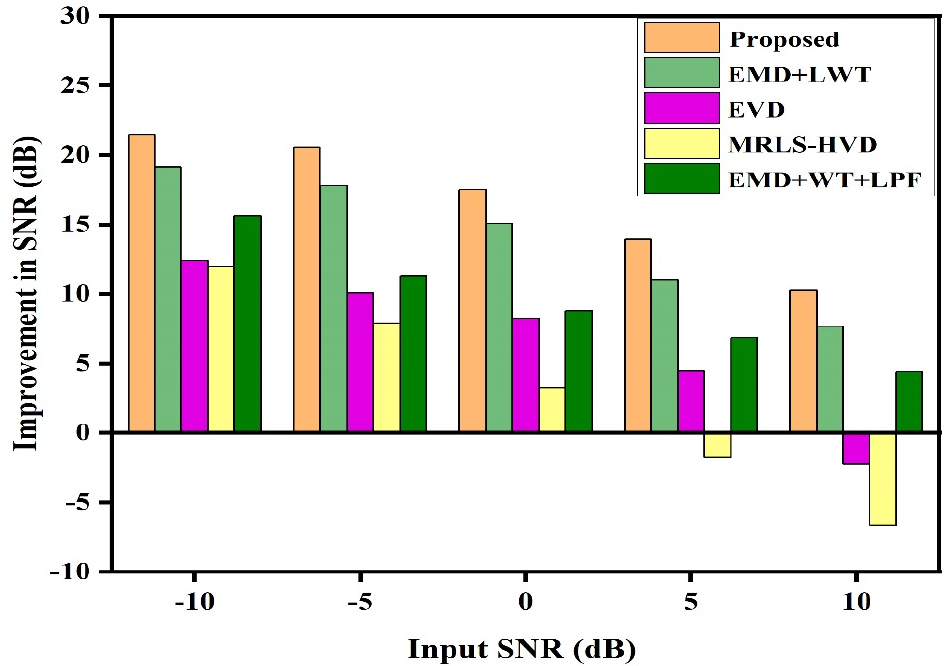
Figure 14. Comparison between the proposed method and various other methods in terms of average improvements generated in the output SNR in presence of 60 Hz PLI and baseline wander.